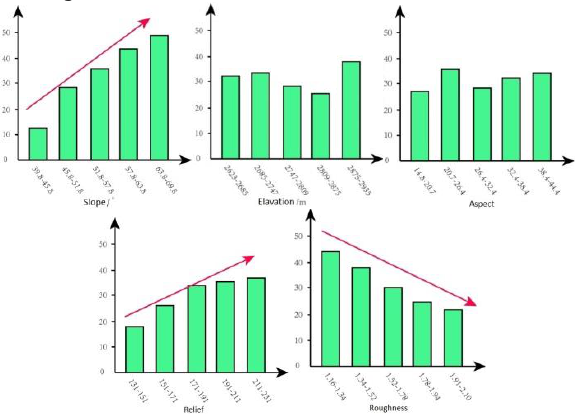
Figure 6. Spatial distribution of earthquake landslides under different topographic